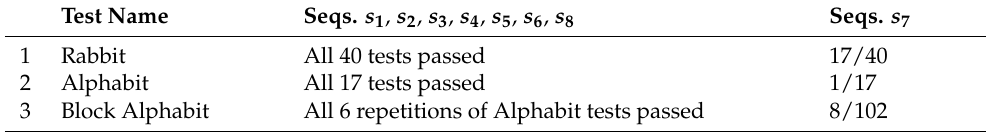
Table 2. Results of applying the TestU01 to the generated